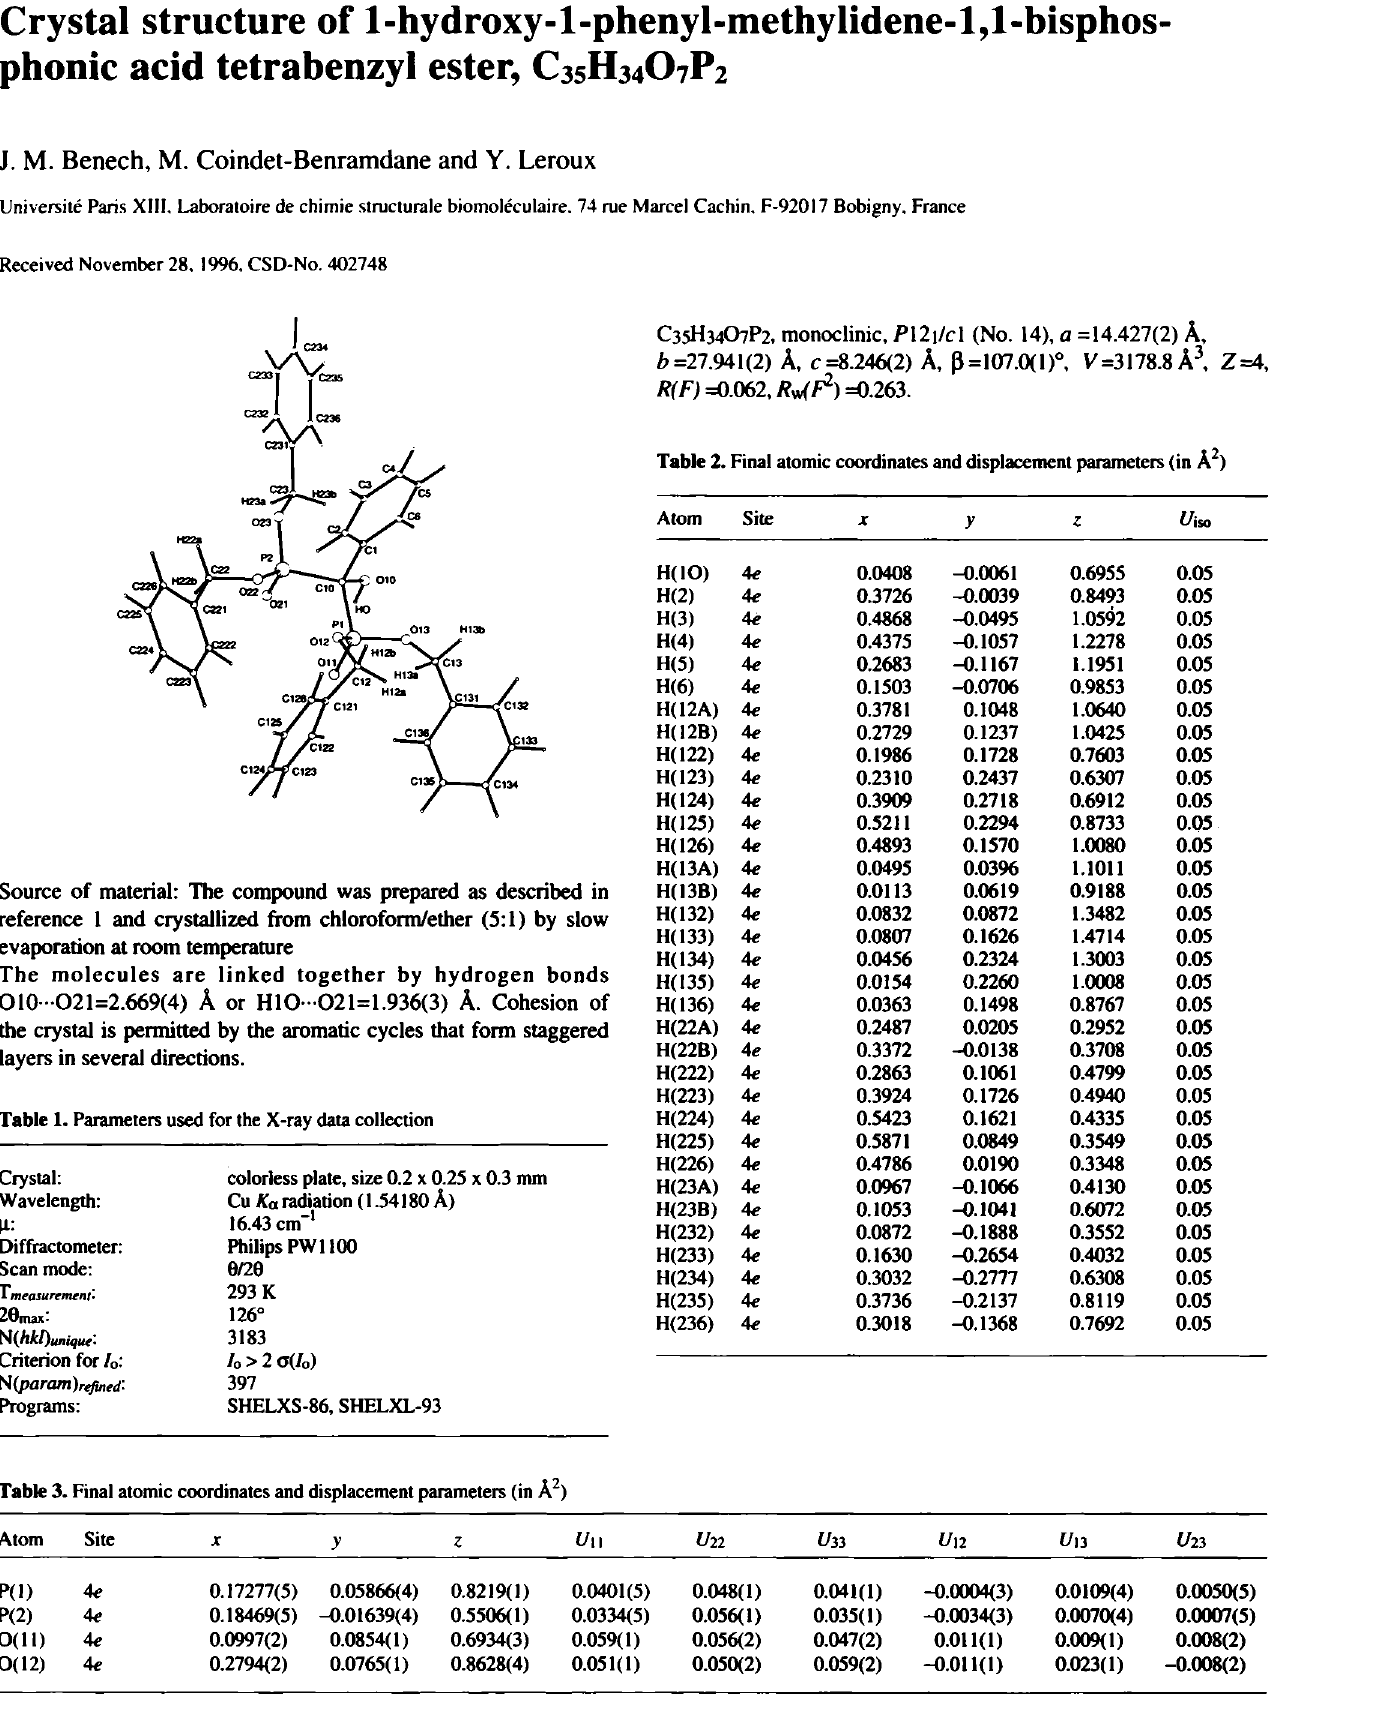
Table 1. Parameters used for the X-ray data collection Crystal: